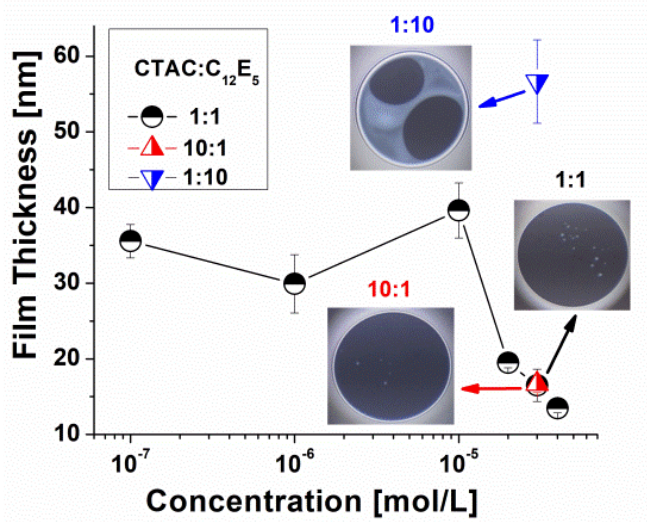
Figure 5. Critical film thicknesses of aqueous solutions of mol:mol = 1:1 CTAC / C 12 E 5 mixtures against